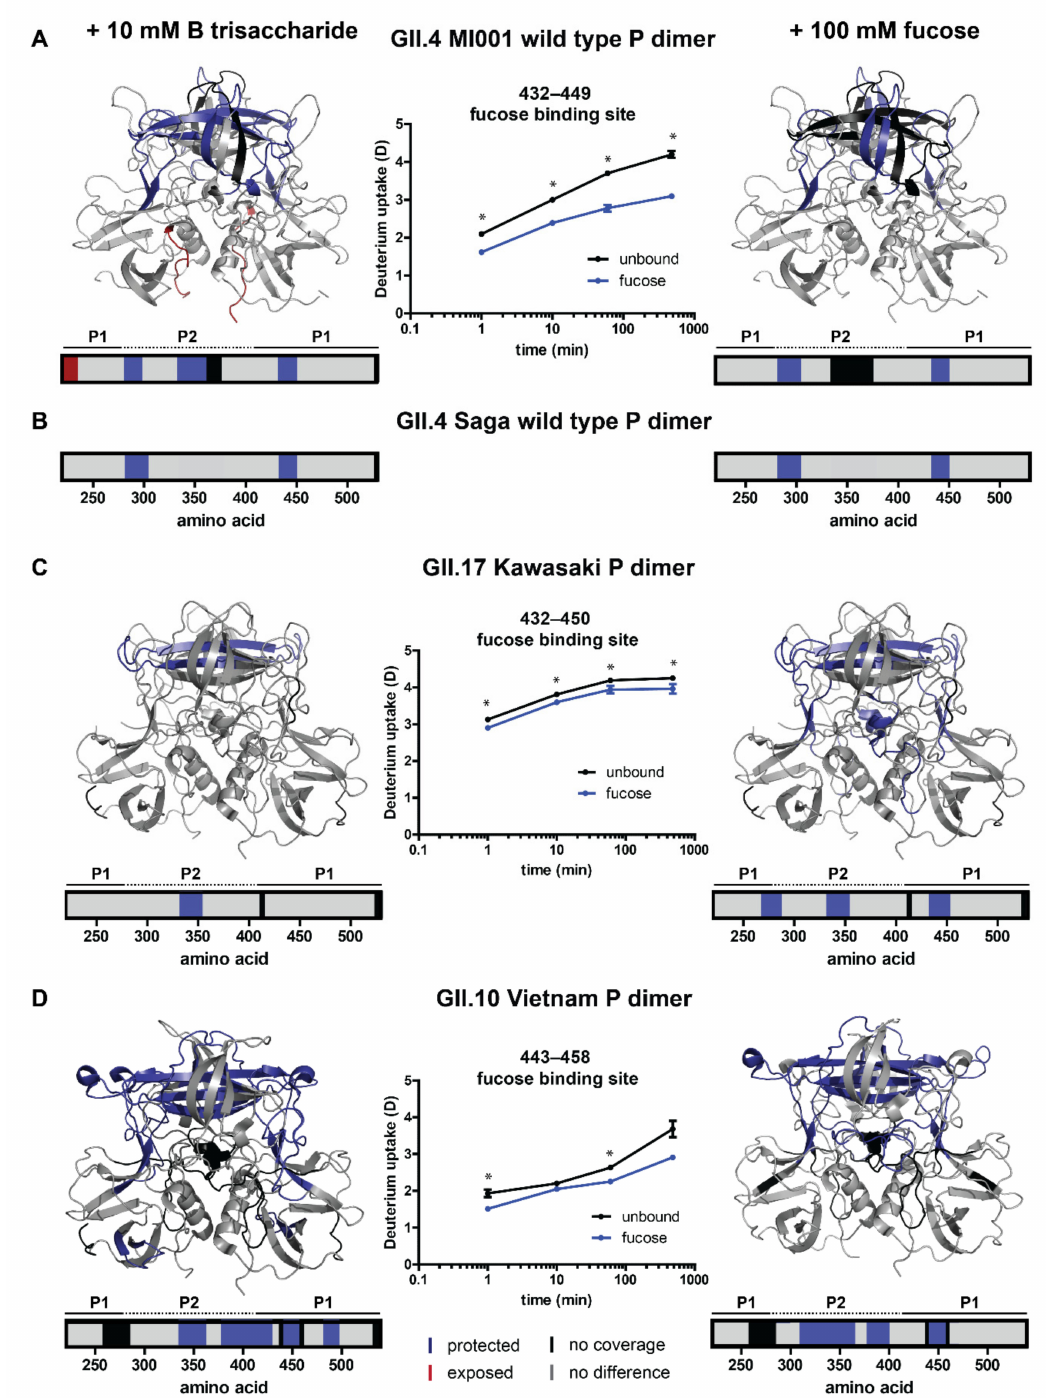
Figure 3. HDX differences upon glycan binding in human GII.4 MI001 ( A ), GII.17 Kawasaki 308 ( C ) and GII.10 Vietnam ( D ) norovirus P dimers. ( B ) Protected regions in wildtype GII.4 Saga P dimers are shown for comparison [15]. Depicted are protein regions with significant deuterium uptake differences in the second (main) peak distribution between unbound P dimers and P dimers with either 10 mM HBGA B trisaccharide or 100 mM fucose ( p < 0.05, Student’s T -test and ∆ D > 2x pooled average SD, Table S4). Deuterium uptake plots show significant (*) protection of the canonical fucose binding site. The deuteration difference at the 8 h time point of GII.10 Vietnam is not considered significant based on the applied criteria because the fucose state only represents a single measurement and thus no Student’s T -test can be applied. In case of bimodal spectra, deuteration differences were manually validated by binomial fitting. Error bars indicate the standard